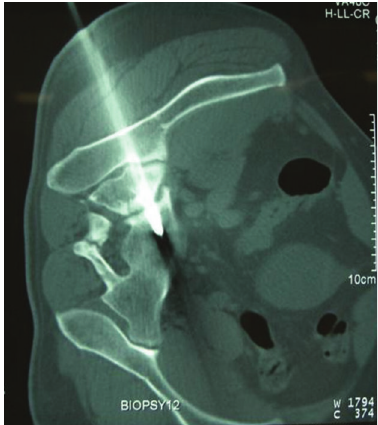
Figure 2: A CT image of the pelvis, showing a guide pin advanced through the iliac wing across the sacroiliac joint to the mid-body of